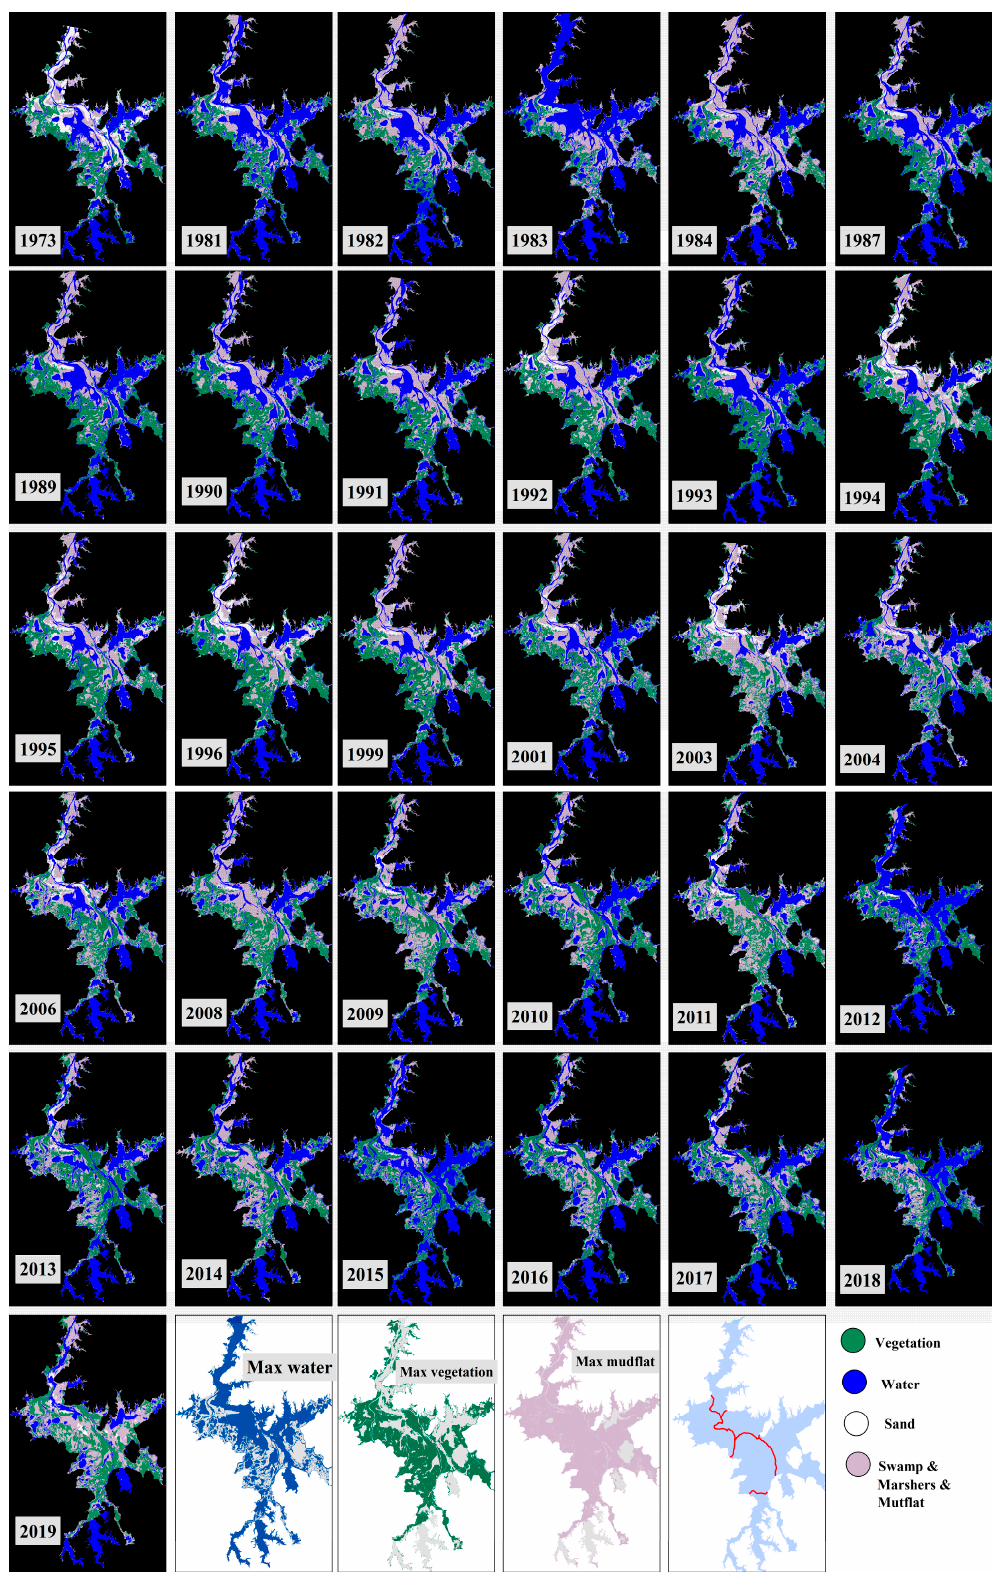
Figure 3. A time series distribution of the main four wetland types in Poyang Lake from 1973 to 2019 (In some periods, there were no images available, and the red lines are the boundary of the six regions shown in Figure 1).